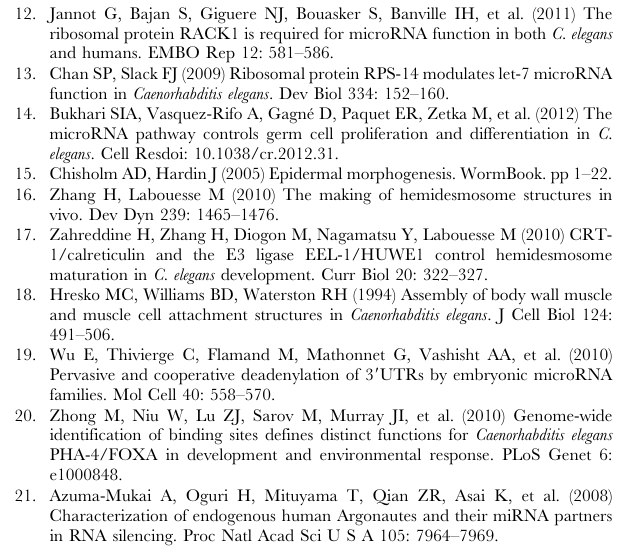
Figure S1 ALG-1 and ALG-2 expression profiles.